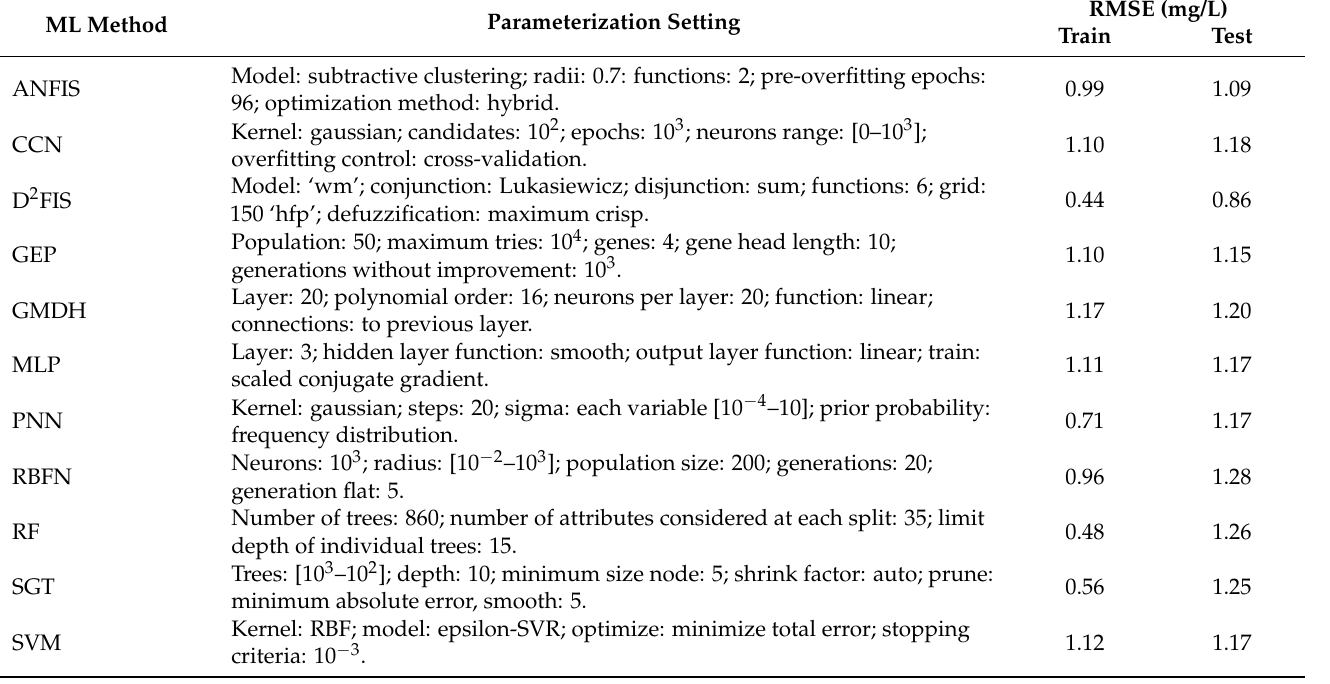
Table 2. Overall accuracy of each ML method based on the RMSE. ML Method Parameterization